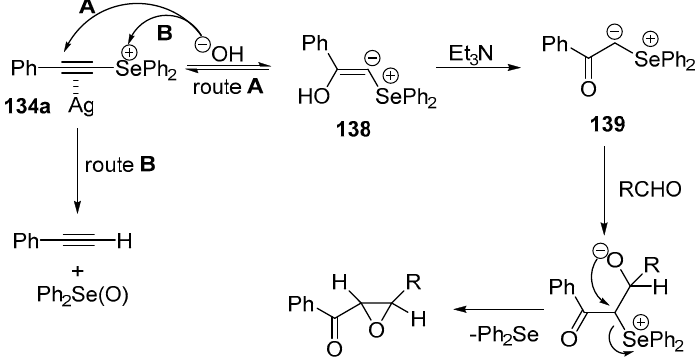
Table 11. Aziridines 137a – d obtained in the reaction of alkynylselenonium salt 134a with aromatic aldehydes and